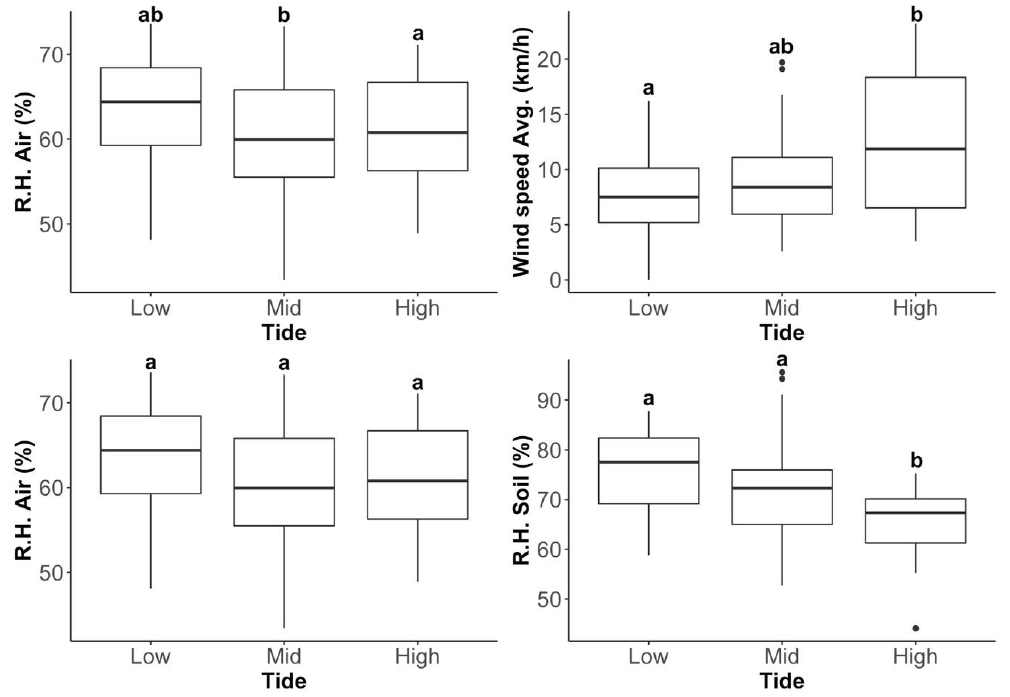
Figure 6. Air temperature, average wind speed, as well as air and substrate R.H. across the three tidal zones (low, mid and high). Means with the same letter are not significantly different at p < 0.05 (Pairwise Wilcoxon Rank Sum Tests).